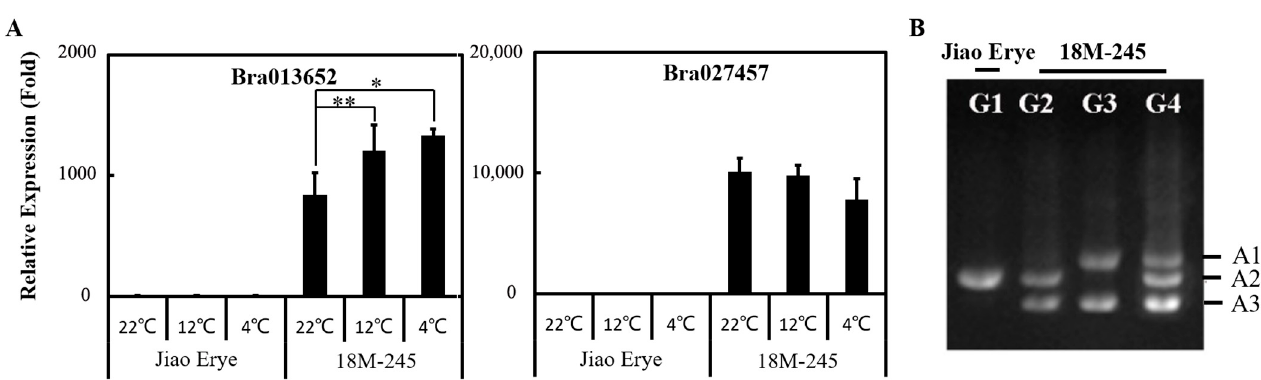
Figure 4. BrLDOX transferred from the B genome is highly expressed in 18M-245. Expression of anthocyanin-related structural genes BrLDOX and BrDFR at different temperatures was analyzed using RT-qPCR ( A ). Expression of BrLDOX was induced, while BrDFR expression decreased after low-temperature treatment. GADPH was used as internal control. Genotypes of green and purple Chinese cabbage ( B ). The 2016 bp A1 band and 1605 bp A2 band correspond to the Bra013652 gene sequence, while the 1306 bp A3 band corresponds to the BjuB014115 gene sequence. Data are shown as the mean value ± SE. At least three biological repeats of each RT-qPCR experiment were performed. Asterisks indicate significant differences; Student’s t -test (* p < 0.05, ** p < 0.01).